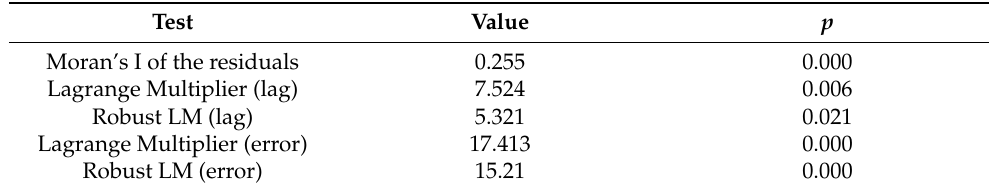
Table 4. The diagnostics for spatial dependence of the OLS regression model.